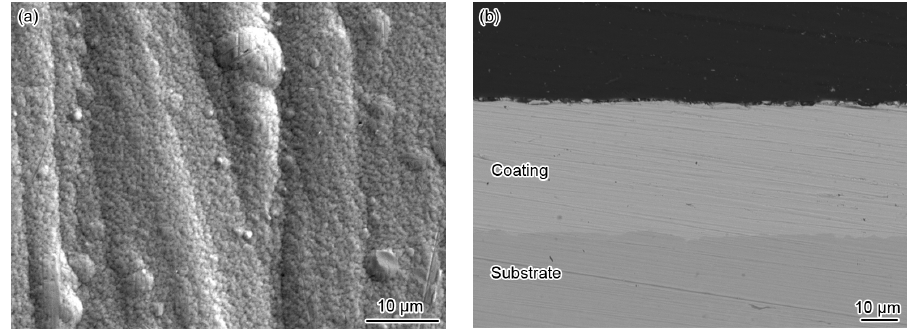
Figure 1. ( a ) SEM surface morphology and ( b ) cross-sectional backscattered electron image of the electrodeposited Ni-based alloy coating.